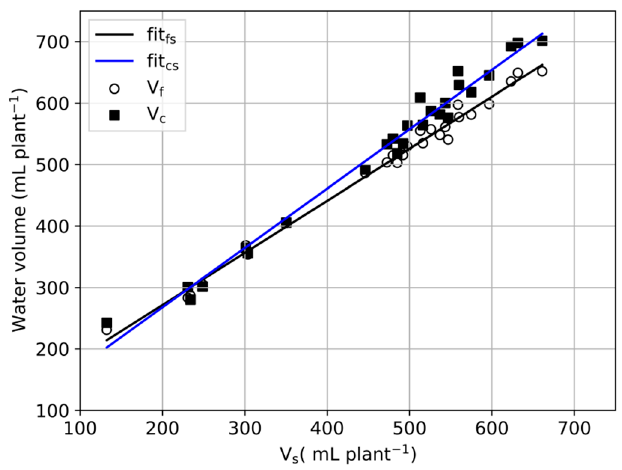
Figure 7. Scatter plot of V f –V s . and V c –V s . during experimental days.